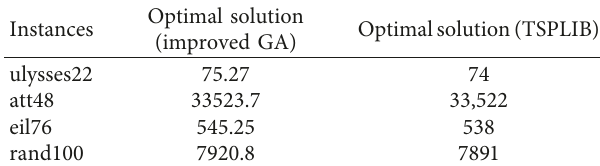
Table 3: Comparison of the improved GA and TSPLIB.